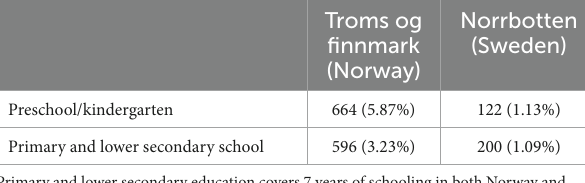
TABLE 1 Children with Sámi as language of tuition in